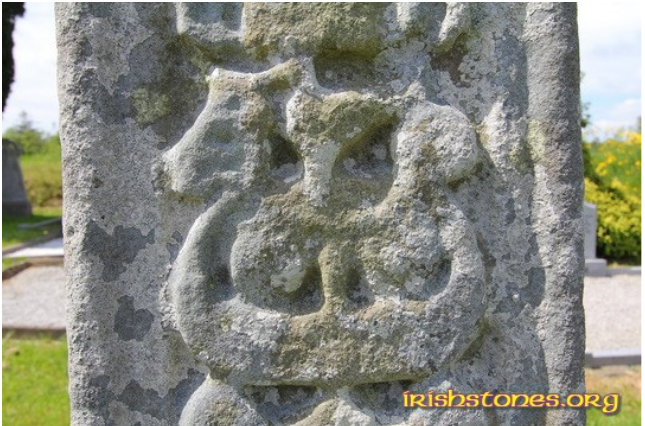
Figure 4. Noah’s Ark, E3, Killary cross. Ninth–tenth century. Killary, Co. Meath.